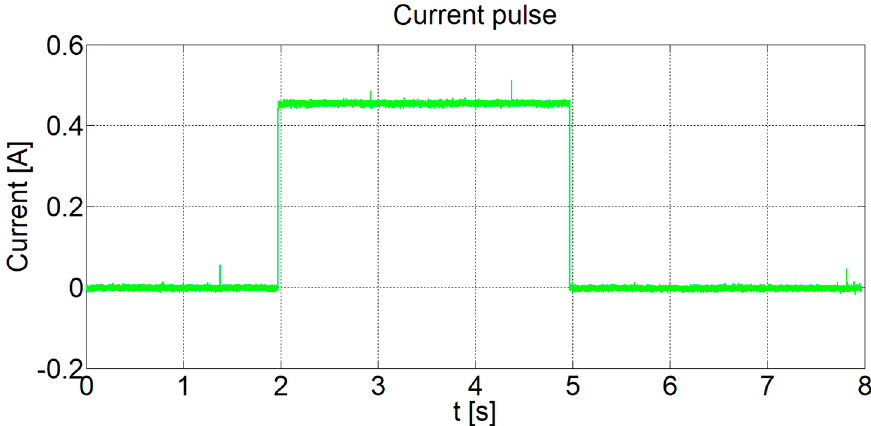
Figure 6. Current pulse.